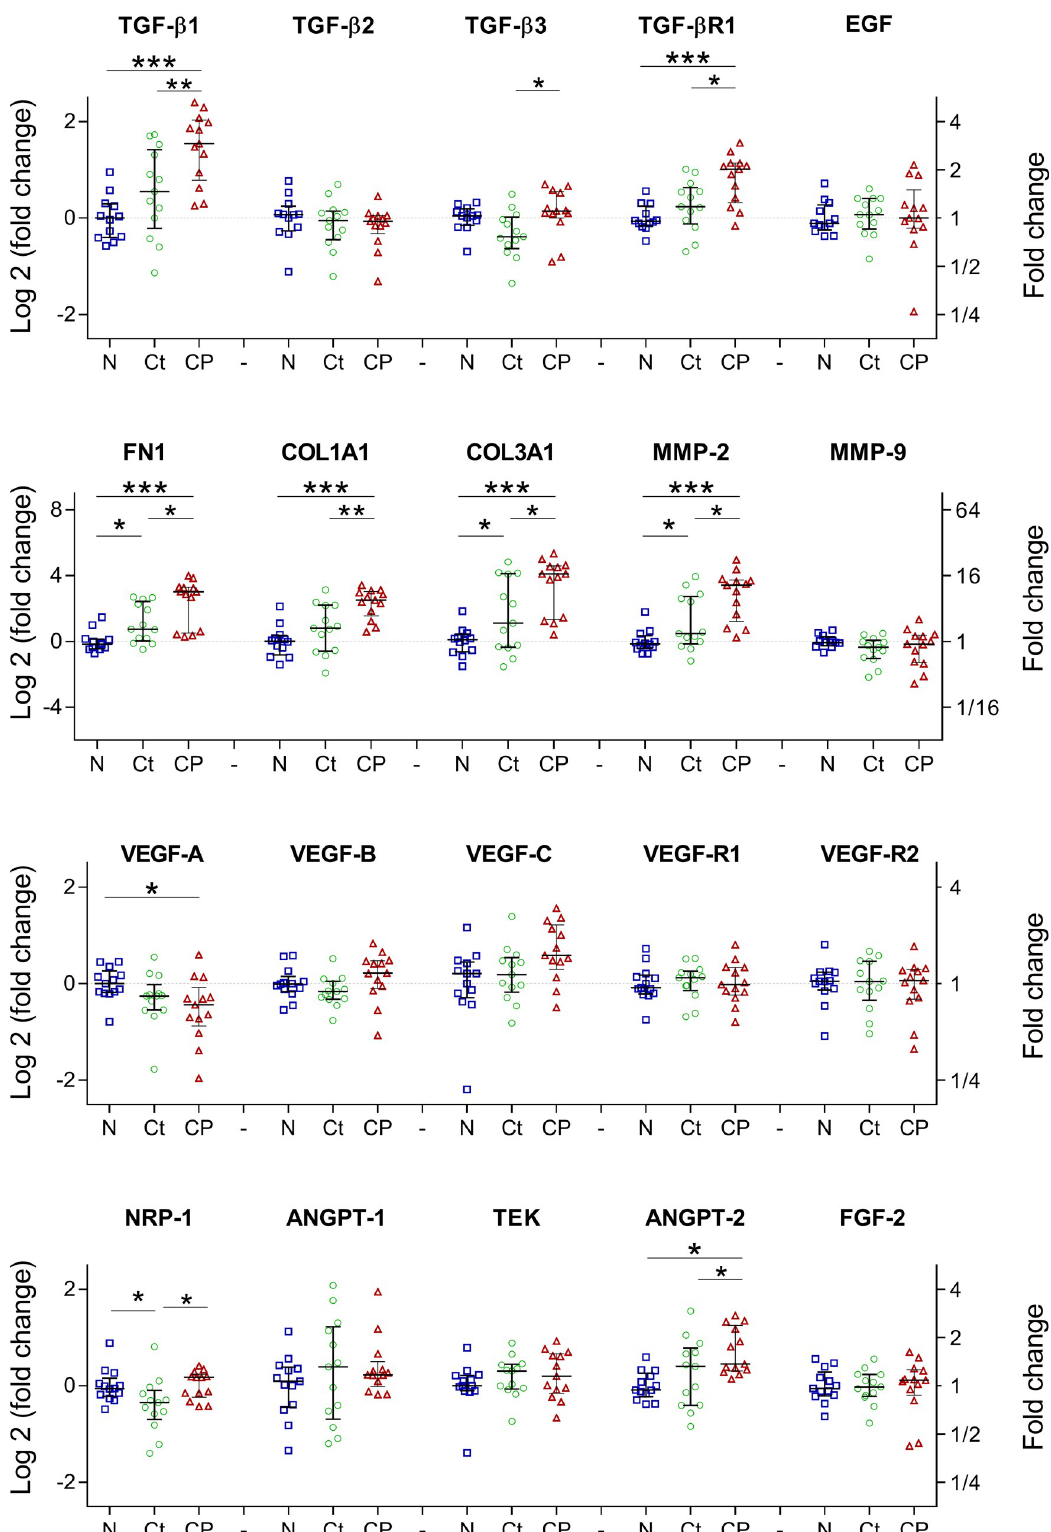
Fig 3. TGF- β and fibrosis-related genes were overexpressed in NCC. Tissue close to the parasite (CP) and contralateral region (Ct) were compared against non-infected tissue (N). n = 13 infected tissues for CP and Ct, n = 12 non-infected tissues. � P < 0.05; �� P < 0.01; ��� P <